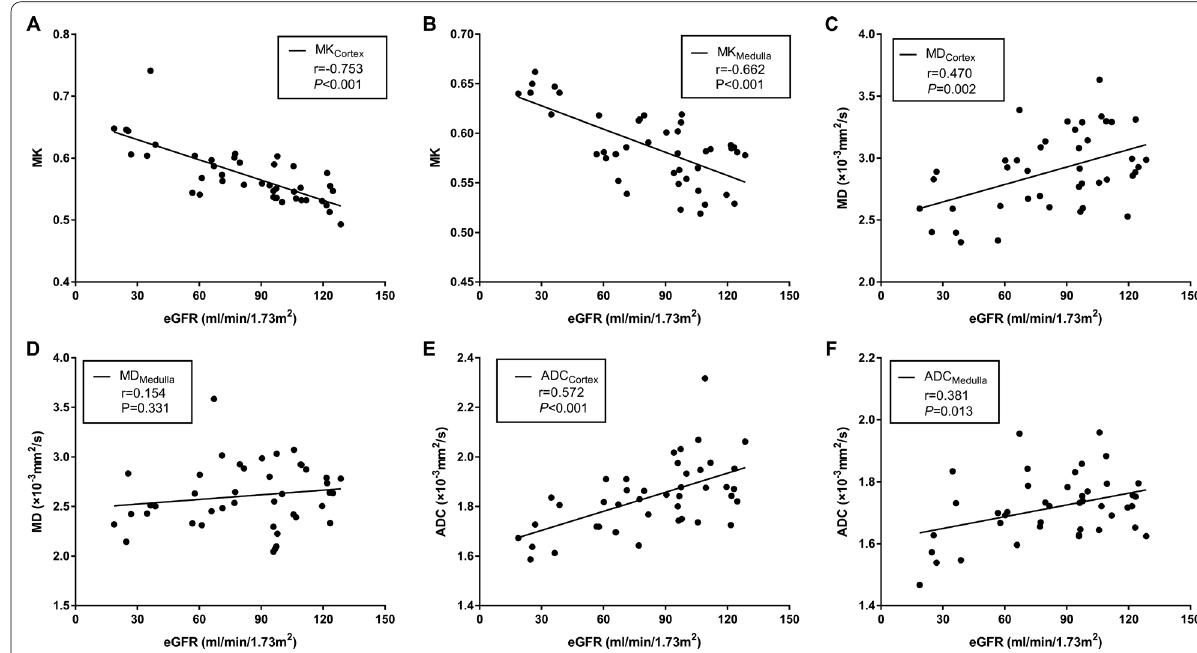
Fig. 6 Correlations between cortical and medullary diffusion parameters and eGFR